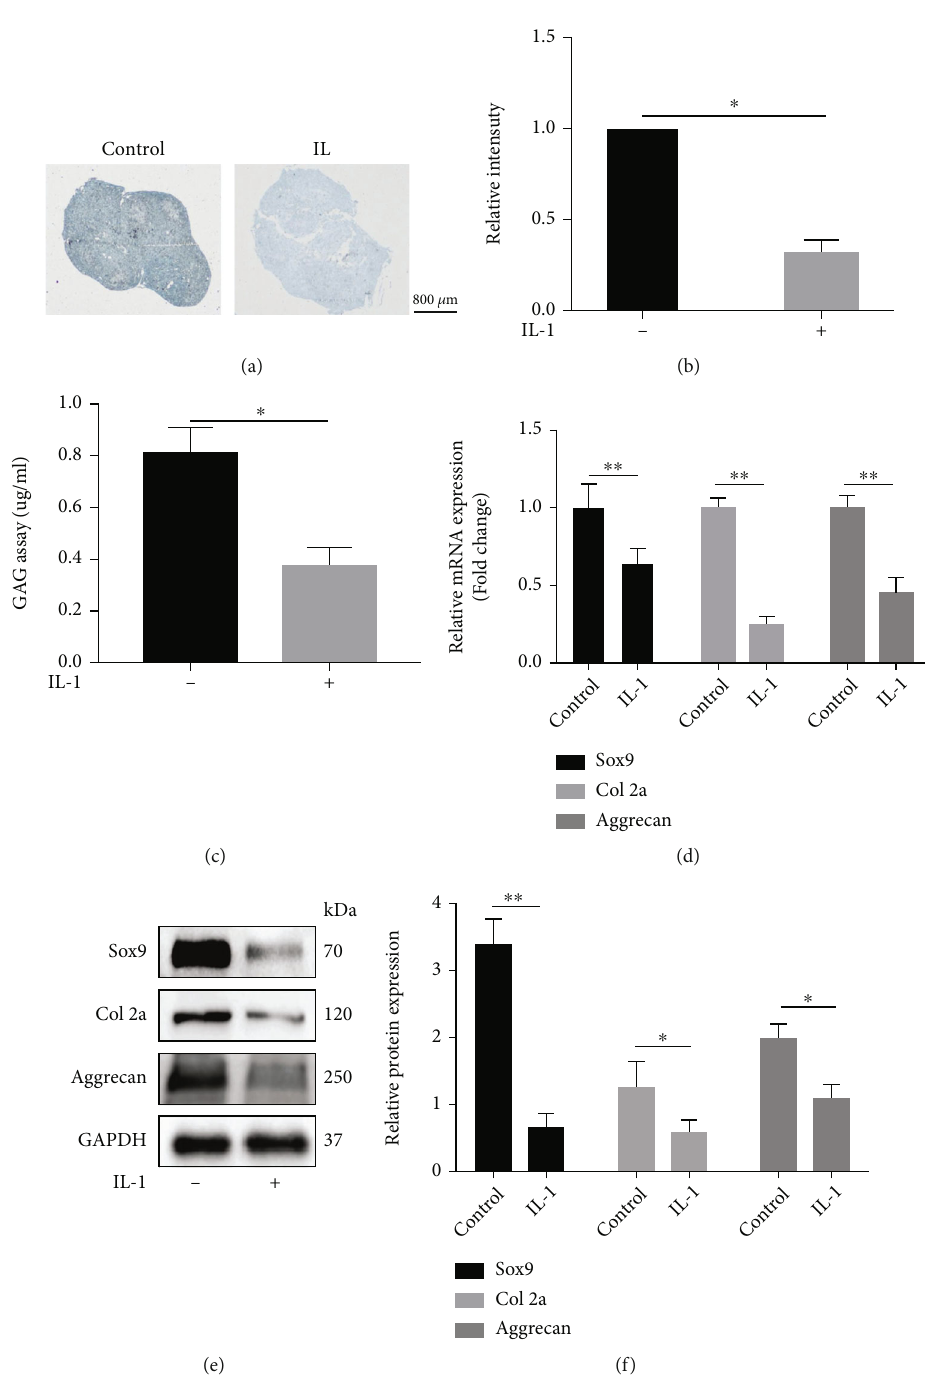
Figure 1: Chondrogenic di ff erentiation of BMSCs in an IL-1 β -induced in fl ammatory microenvironment. (a) and (b) Representative images and intensity quanti fi cation of Alcian blue staining. (c) The GAG content in the culture medium. The expression level of Sox9, Collagen 2a and Aggrecan were detected by qRT-PCR (d) and western blotting (e) and (f). All results are expressed as the mean ± SD ( n = 3 ). NS: not signi fi cant, ∗ P < 0 : 05 and ∗∗ P < 0 : 01 . Bar = 800 μ